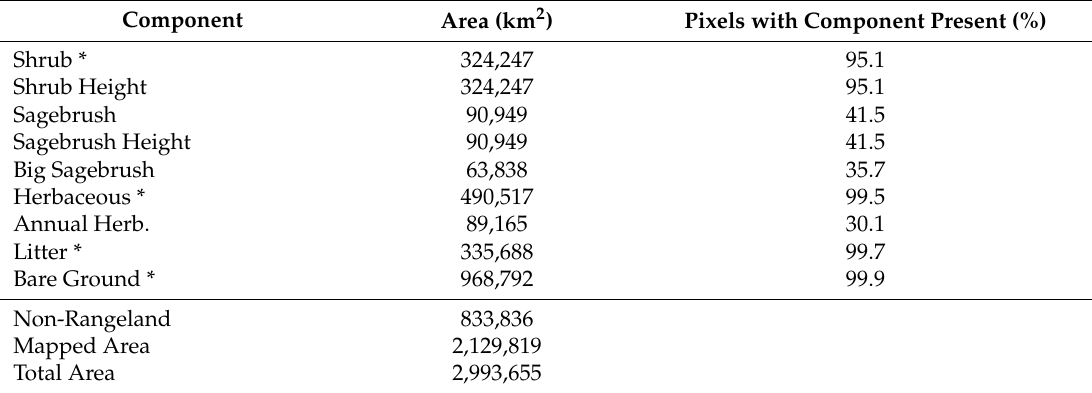
2,993,655 * Indicates a primary component, which represents 100% of the mapped area when added together with tree